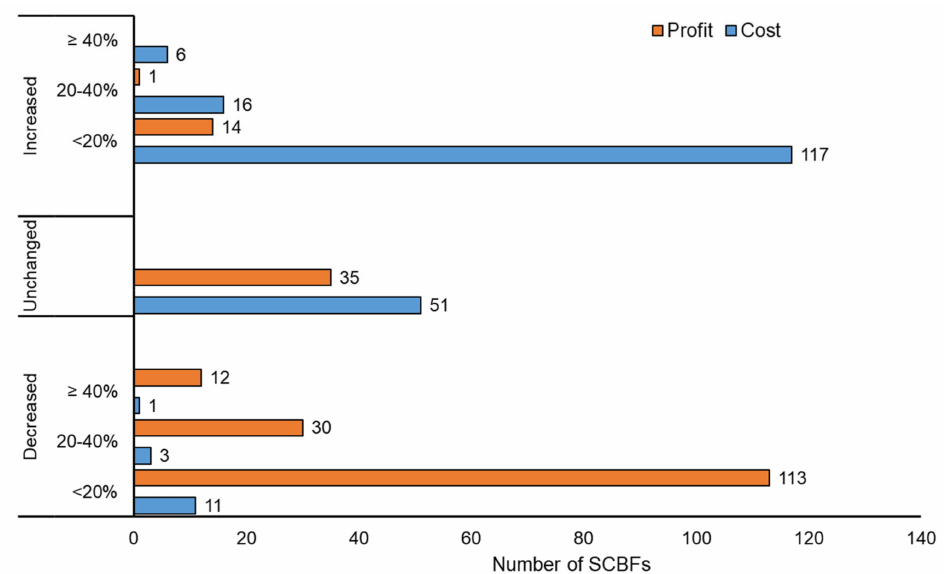
Figure 2. Changes in farm production costs and profitability in the first half of 2020 compared to the corresponding period in 2019 ( n =